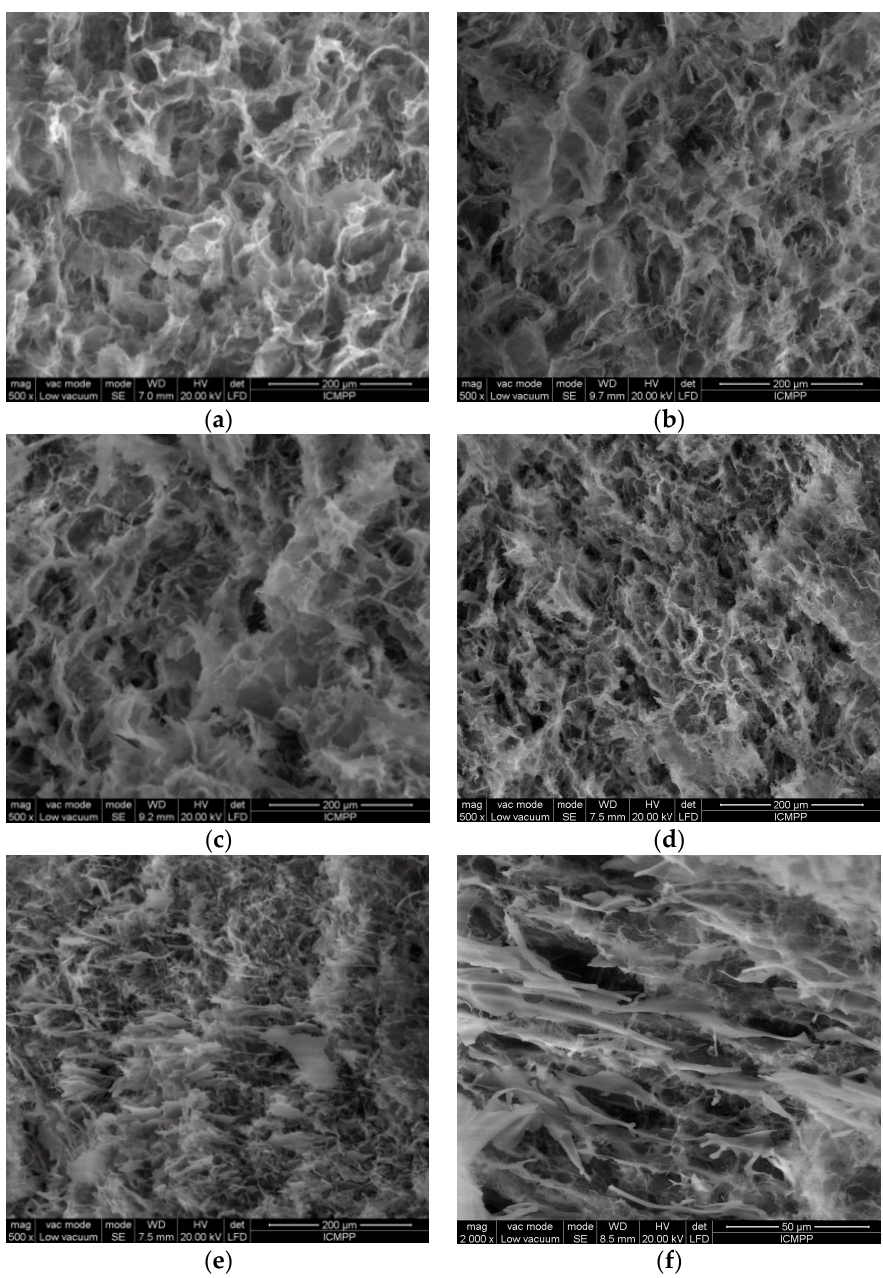
Figure 4. SEM micrographs of lyophilized hydrogels with different w BSA : ( a ) 0; ( b ) 0.1; ( c ) 0.2; ( d ) 0.5; ( e ) 0.8; ( f ) 0.9.